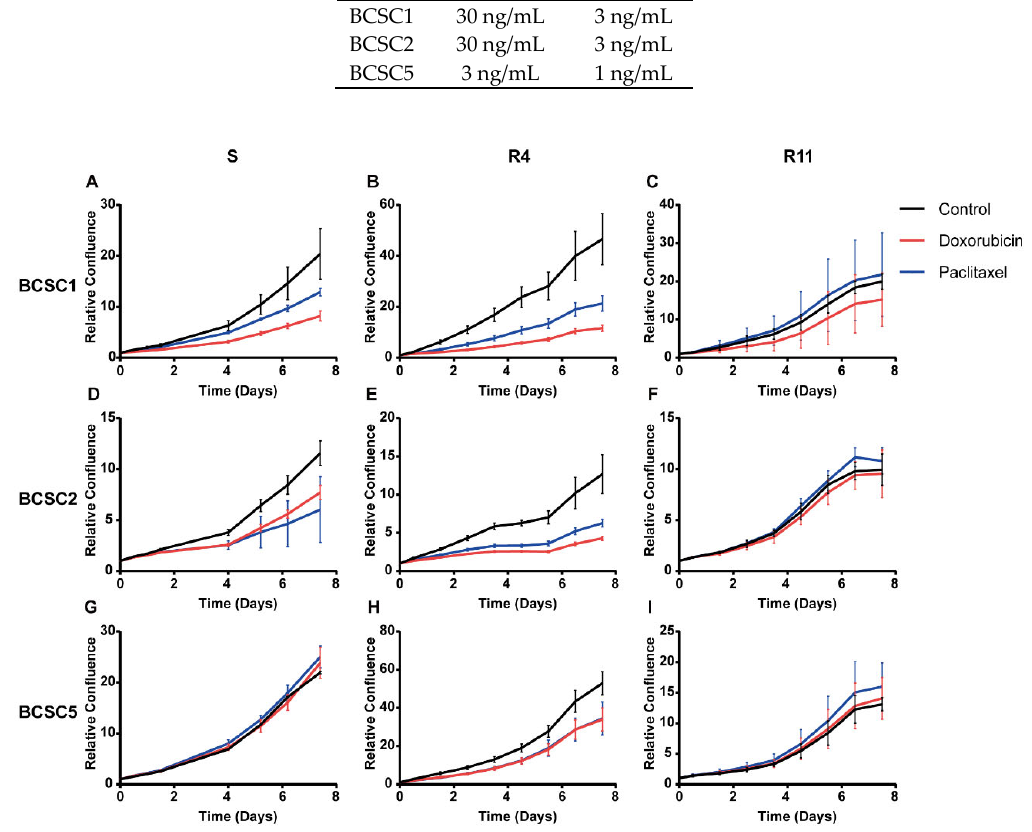
Figure 3. Proliferation of BCSCs was inhibited after chemotherapeutic stress and recovered gradually. BCSCs that survived doxorubicin and paclitaxel treatment were cultured in standard medium to observe their recovery. Surviving cells (S) and recovered cells for 4 days (R4) or 11 days (R11) were harvested and seeded for proliferation analysis. ( A – C ) Proliferation analysis for BCSC1 that survived (S) and recovered (R4, R11) from doxorubicin and paclitaxel. ( D – F ) Proliferation analysis for surviving and recovered BCSC2. ( G – I ) Proliferation analysis for surviving and recovered BCSC5. The n = 3, data represent means ±